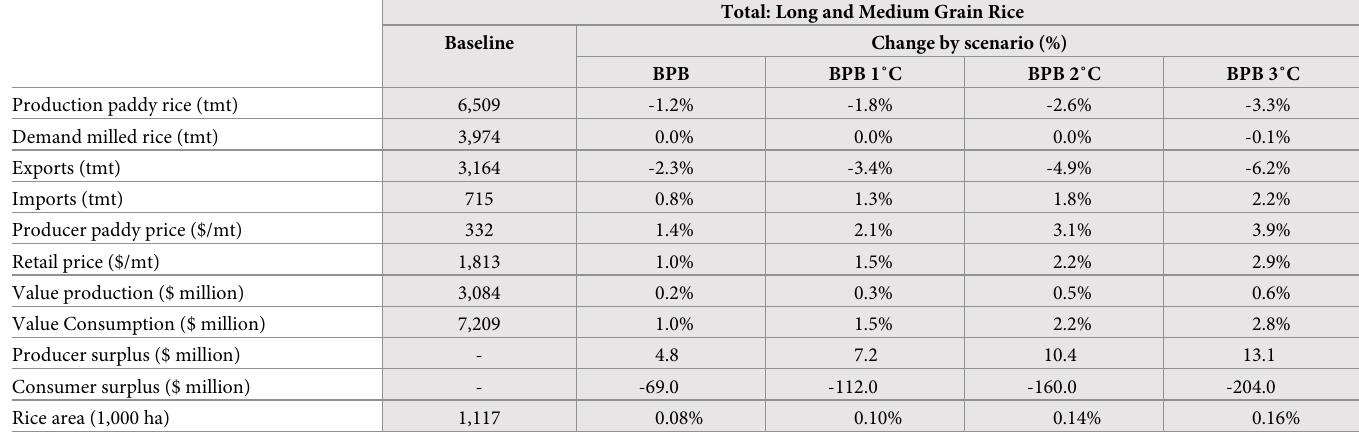
Table 4. Estimated economic impact of a Bacterial Panicle Blight (BPB) occurrence under current (BPB) and 1˚C warming conditions (BPB 1˚C) on selected U.S. market variables relative to the baseline market average in